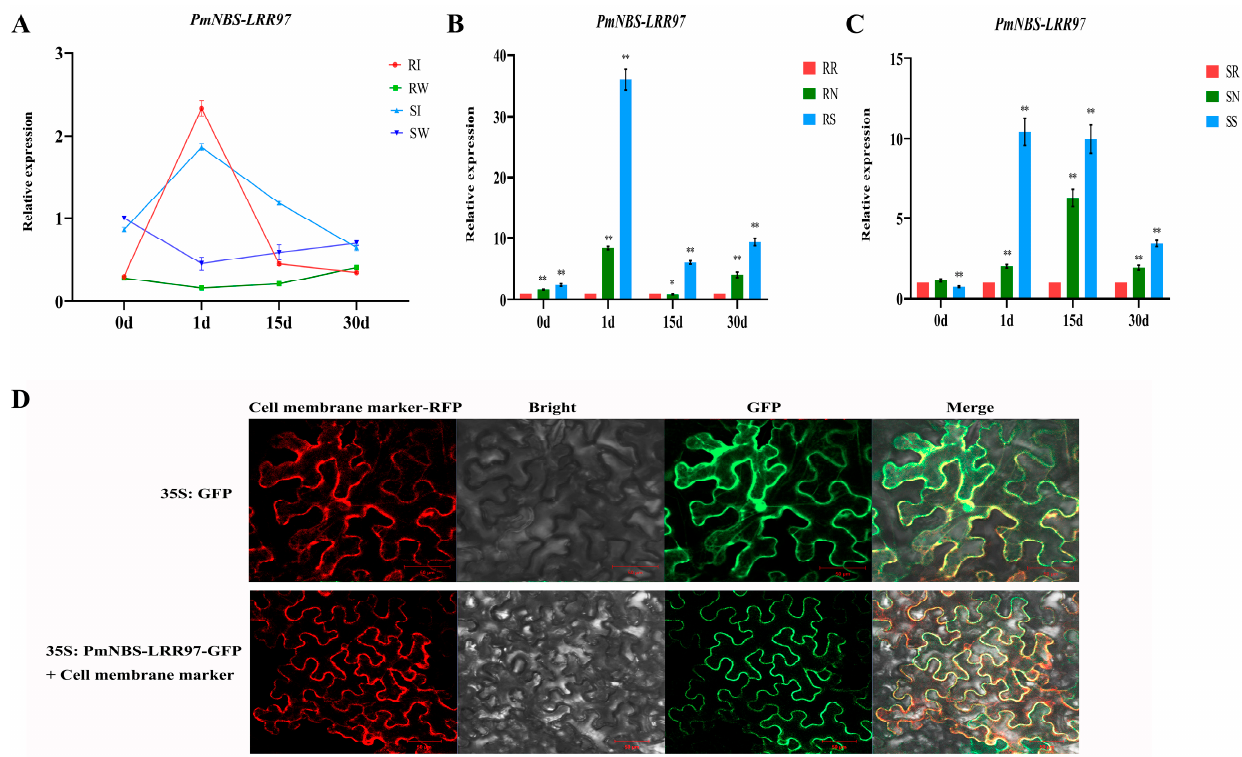
Figure 4. Expression pattern and subcellular localization of PmNBS-LRR97 in resistant and susceptible P. massoniana . ( A ) Expression patterns of PmNBS-LRR97 in resistant and susceptible P. massoniana inoculated with the PWN at 0, 1, 15, and 30 dpi. Error bars represent three biological replicates ± SD. RI and RW represent resistant P. massoniana inoculated with the PWN and water, respectively; SI and SW represent susceptible P. massoniana inoculated with the PWN and water, respectively. Susceptible P. massoniana at 0 days of water inoculation served as a control. ( B ) The expression patterns of PmNBS-LRR97 in different tissues at different stages of the resistant P. massoniana inoculated with the PWN. Error bars represent three biological replicates ± SD. RR, RN, and RS represent the root, stem, and needle of resistant P. massoniana , respectively. The root of resistant P. massoniana was used as the control in each period. ( C ) The expression patterns of PmNBS-LRR97 in different tissues at different stages of susceptible P. massoniana inoculated with the PWN. Error bars represent three biological replicates ± SD. SR, SN, and SS represent the root, stem, and needle of susceptible P. massoniana , respectively. The root of susceptible P. massoniana was used as the control in each period. Student’s t -test was used to test the significance (*, p < 0.05; **, p < 0.01). ( D ) Subcellular localization of the PmNBS-LRR97. Empty vector containing the 35S promoter and PmNBS-LRR97 co-localized with cell membrane markers, respectively. Scale bar = 50 μ m. 2.5. Overexpression of PmNBS-LRR97 Enhances Plant Growth and Increases the Content of Defense Signaling Molecules PmNBS-LRR97 was transformed in N. benthamiana to verify its function, because the genetic transformation system of P. massoniana has not been successfully established. The qRT-PCR results demonstrated that, compared with WT, the PmNBS-LRR97 expression levels of all transgenic tobacco lines were higher, with those of PmNBS-LRR97 -OE5, PmNBS-LRR97 -OE4, and PmNBS-LRR97 -OE3 being the greatest; hence, these three lines were used for further verification (Figure 5A). To explore whether PmNBS-LRR97 can affect plant growth, the phenotypes of WT and transgenic tobacco were observed (Figure 5B–D). The transgenic tobacco plants were taller than WT counterparts, irrespective of their age (i.e., 30, 60, and 90 d) ( p < 0.01). It was also found that the transgenic tobacco bloomed earlier than WT and had more flowers and greater branching at 90 days, indicating that the overexpression of PmNBS-LRR97 can effectively promote the growth and development of plants.